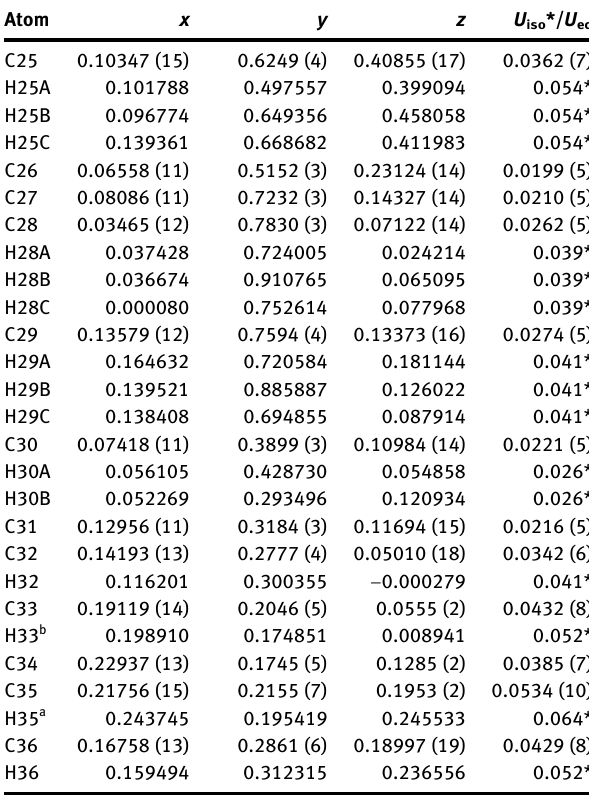
Table  : Fractional atomic coordinates and isotropic or equivalent isotropic displacement parameters (Å 